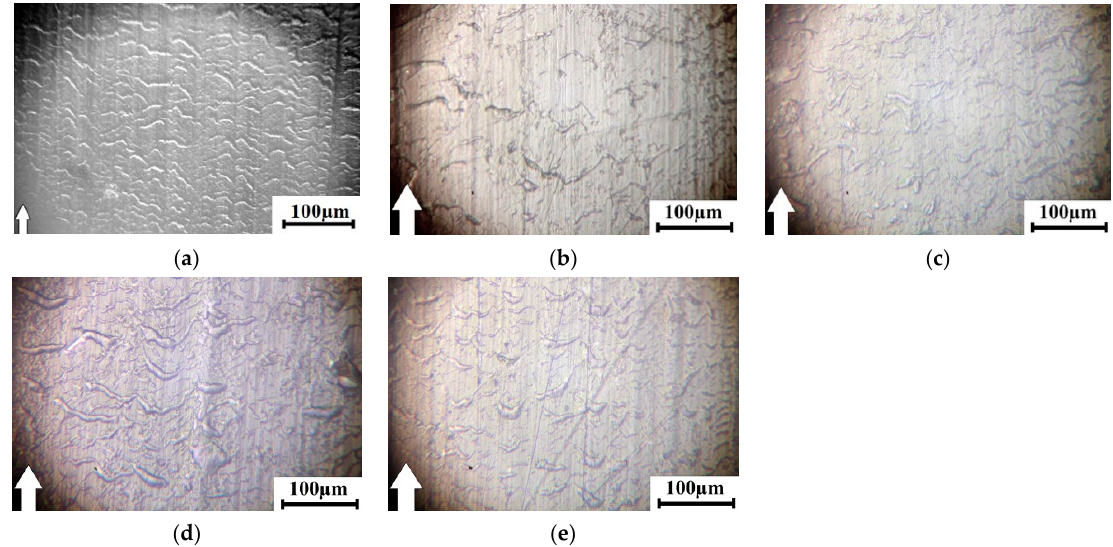
Figure 11. Optical images of the wear track surfaces of neat UHMWPE ( a ); and the “UHMWPE + 7 wt. % wollastonite” composites: untreated ( b ); “KH-550” ( c ); “Penta-1006” ( d ); and “OTS” ( e ) (Load = 140 N, Velocity = 0.5 m · s − 1 ). Appl. Sci. 2020 , 10 , 4511 15 of 31